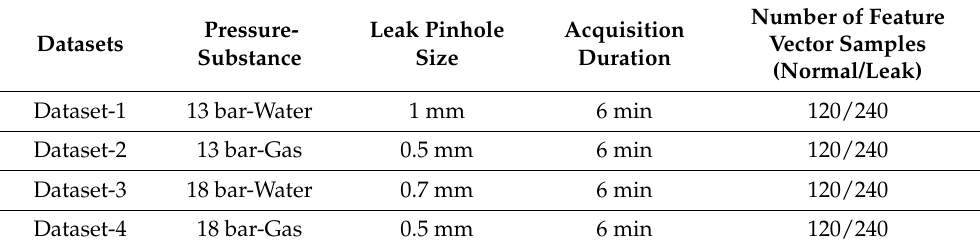
Table 4. Datasets acquisition configuration